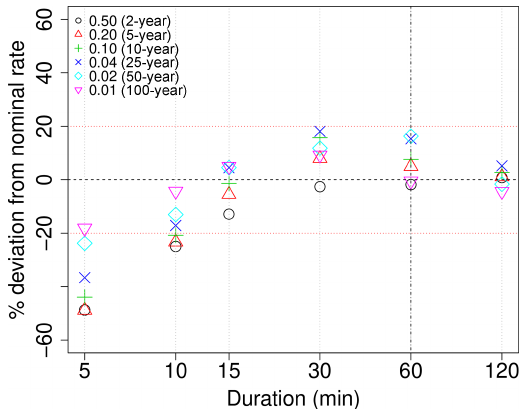
Figure 6. Posterior predictive checks for sub-hourly durations ex- trapolated from GEVSS distributions fitted to observed annual max- ima for durations ≥ 60min. Values are relative deviations from nominal exceedance rates for 2- to 100-year return level estimates (i.e., 50% to 1% chance of exceedance, respectively). Perfect relia- bility is indicated by the horizontal black dashed line; deviations of ± 20% are indicated by horizontal red dotted